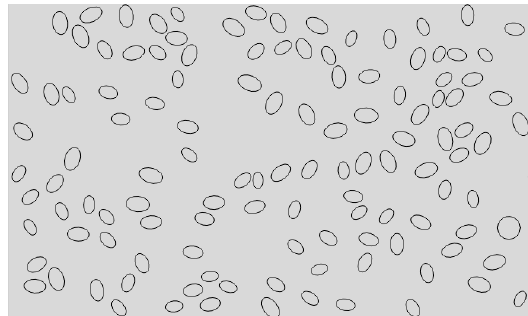
Figure 3. 2D sketch of the model.